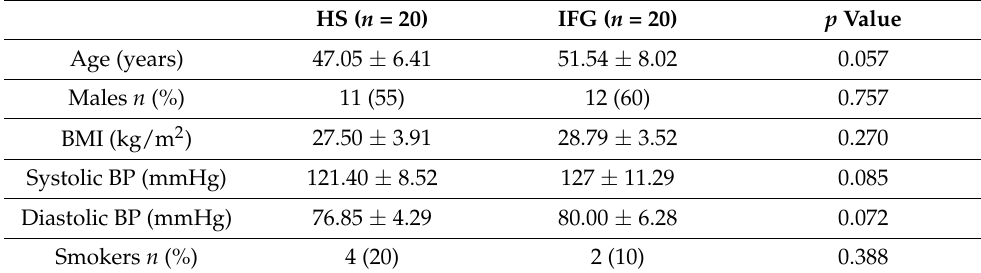
Table 1. Clinical characteristics of the study